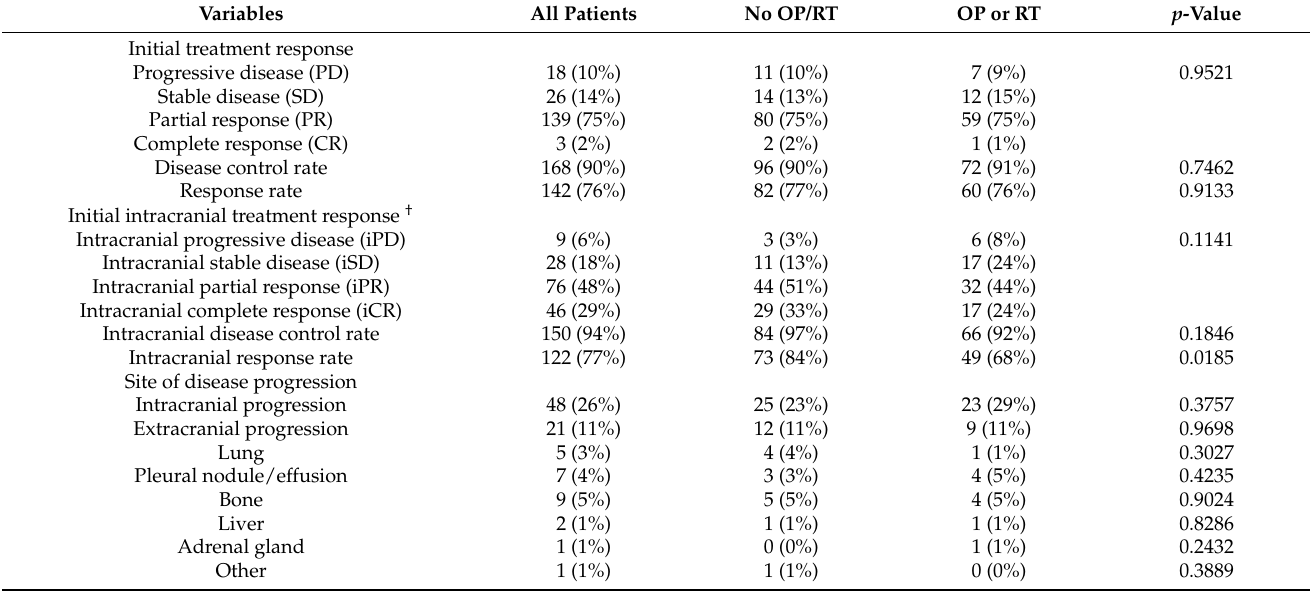
Table A3. Initial treatment response and site of disease